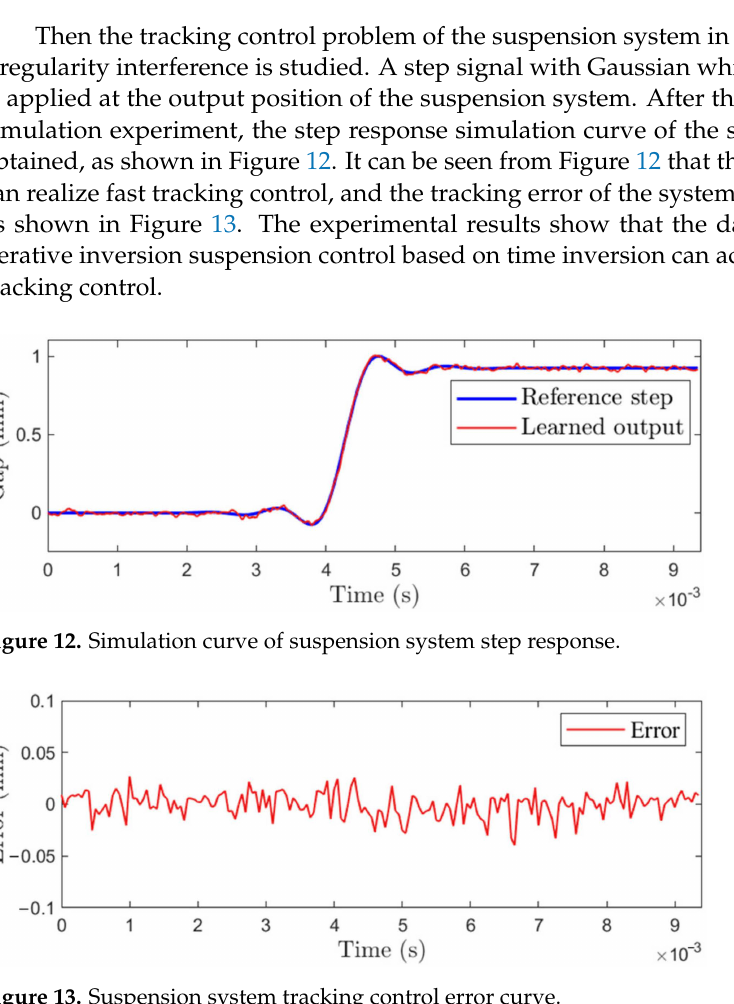
Figure 11. Pulse response tracking error curve after learning filter updating.